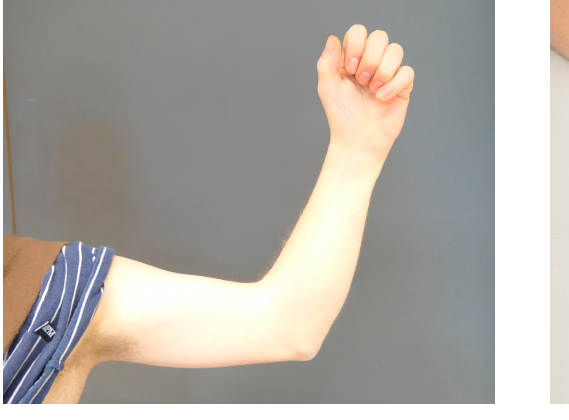
Figure 2. Photographs of patient VI.1. ( a ) Left elbow: the patient has almost complete absence of mobility of the elbow in flexion and extension and for pronation and supination. ( b ) Note the shortened fifth fingers, the missing creases over the distal interphalangeal joints of the fifth fingers and the shortened distal phalanx of the thumbs.